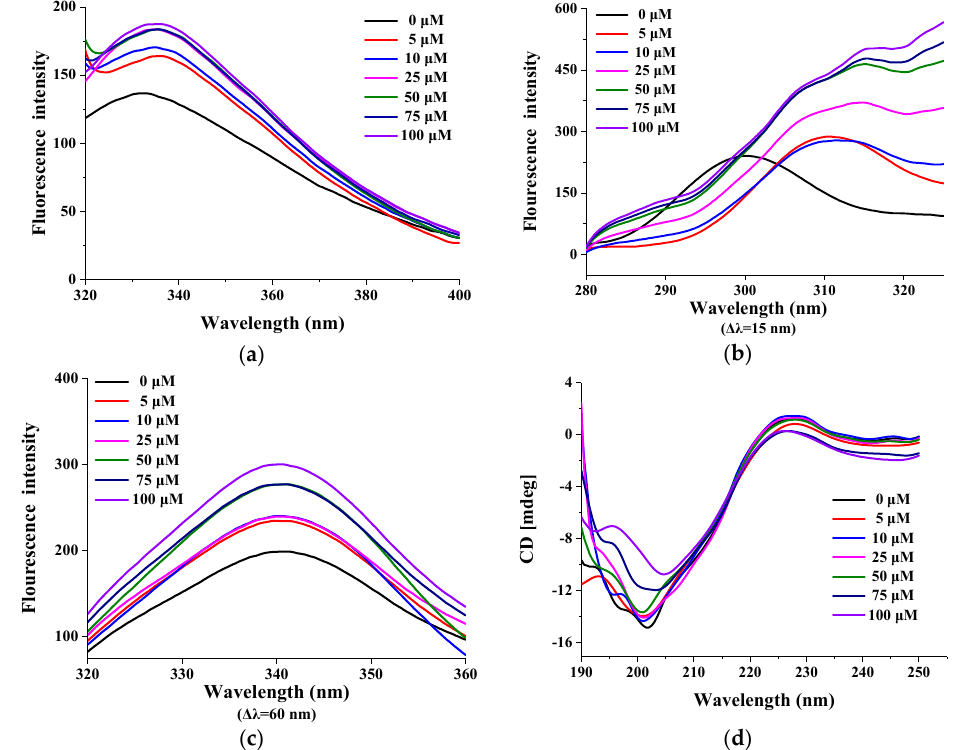
Figure 6. Intrinsic fluorescence spectra ( a ) and synchronous fluorescence spectra ( b , c ) of PHTI with Fe 3+ (0, 5, 10, 25, 50, 75, and 100 μ M, respectively). ( d ) Far-UV CD spectra of PHTI recorded in the presence of different Fe 3+ concentrations in deionized water.